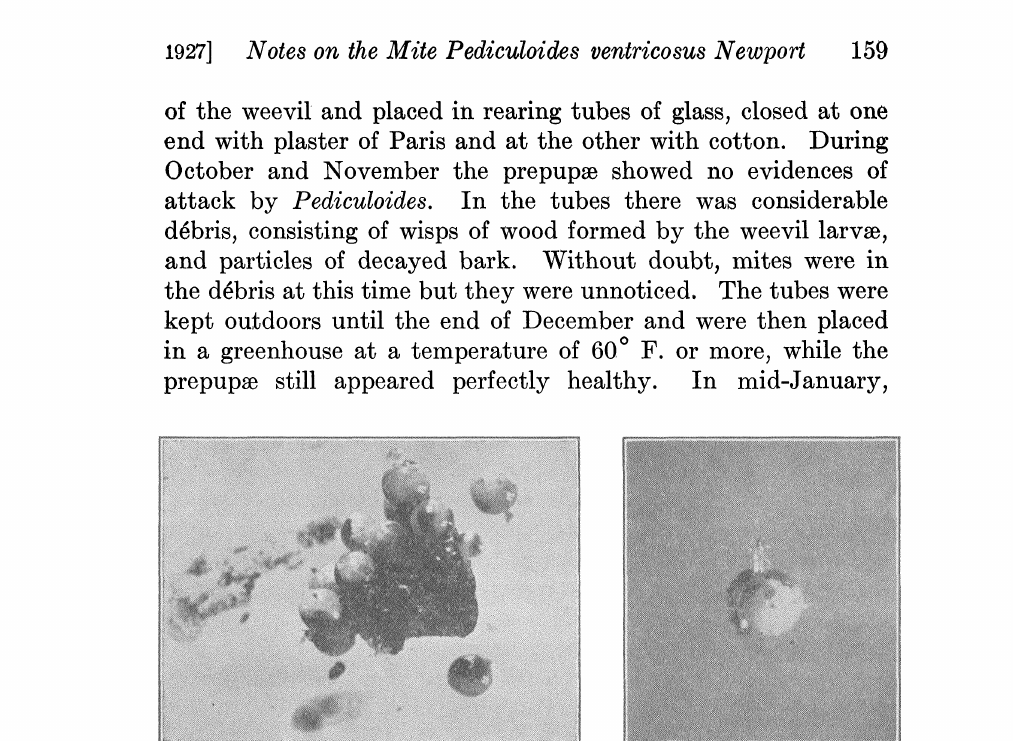
Fig. At left, Eurytoma prepupa infested with mites; at right, gravid female of Pediculoides